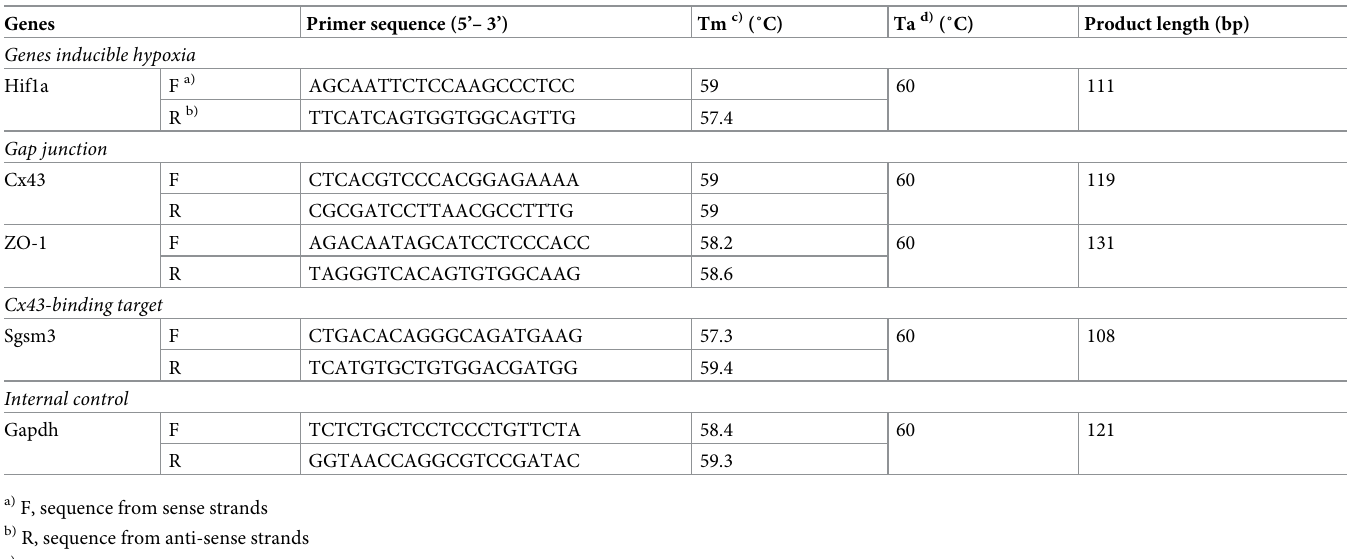
Table 1. Sequences of primers used for quantitative real-time